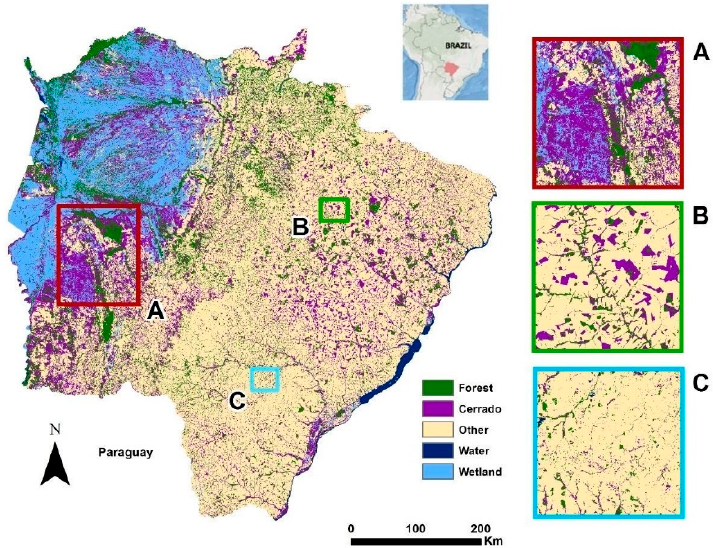
Figure 1. Land cover classification of Mato Grosso do Sul with: ( a ) Largest patches of Cerrado; ( b ) Gallery forests with fragmented Cerrado patches; ( c ) Other (non-native vegetation/agriculture) dominated landscape. Land 2016 , 5 , 12 Table 1. Mato Grosso do Sul landscape metrics.